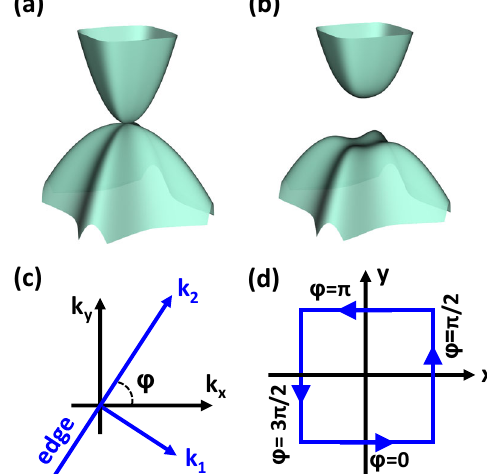
Fig. 2 Quadratic bulk Hamiltonian and edge orientation. a and b Characterized band structures of the low-energy effective Hamiltonian without and with SOC, showing the quadratic touching point and quadratic QSH. c Reciprocal space rotated coordinate system for describing the edge along k 2 direction that has an angle φ with k x axis. d Real space rectangular cluster with four edges, corresponding to φ = 0, π /2, π and 3 π /2 in ( c ). The arrow denotes the positive direction of the